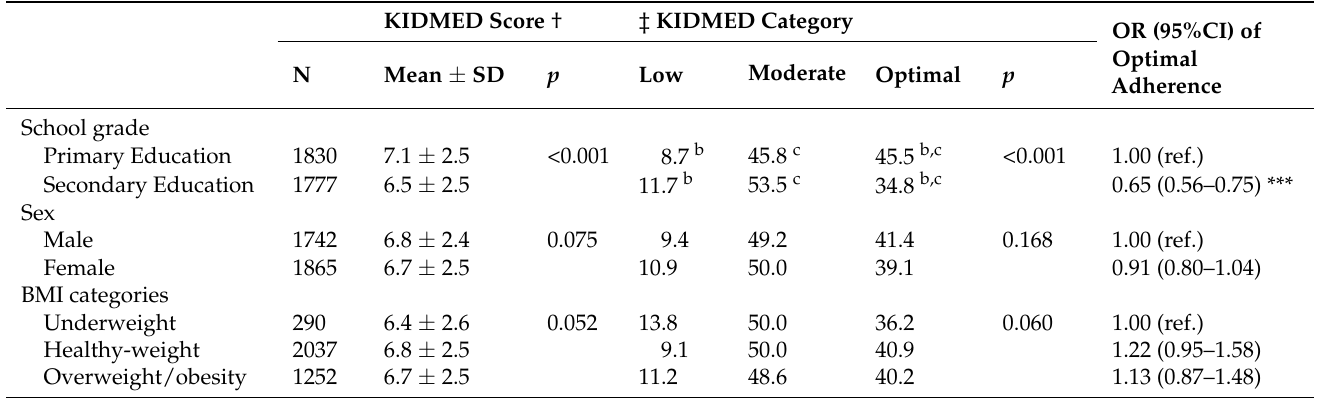
Table 3. Adherence to the MedDiet of the study